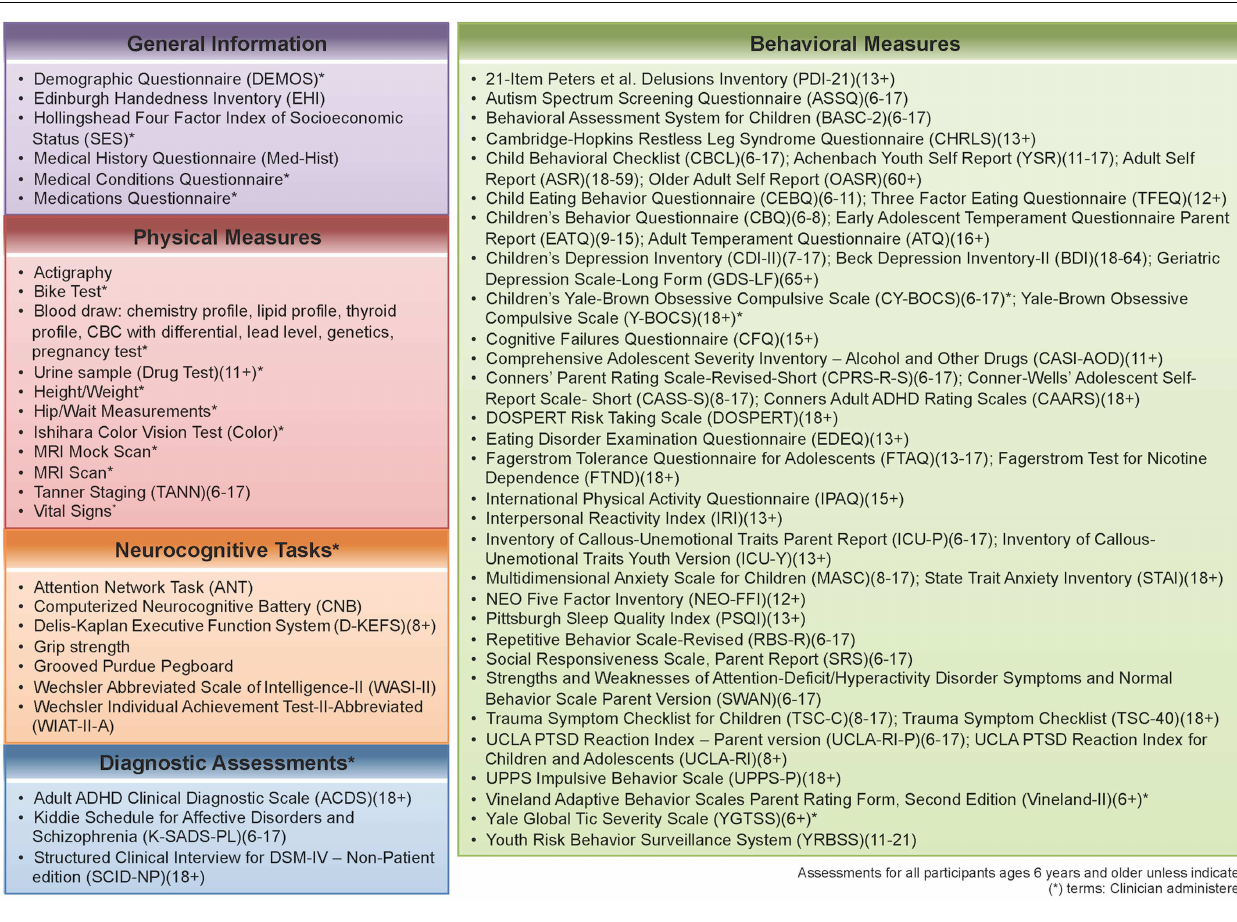
FIGURE 1 |Assessment protocol for NKI-RS. This figure illustrates all of the assessments that are included in the 2-day enhanced Nathan Kline Institute-Rockland Sample (NKI-RS) protocol.There are five broad domains of